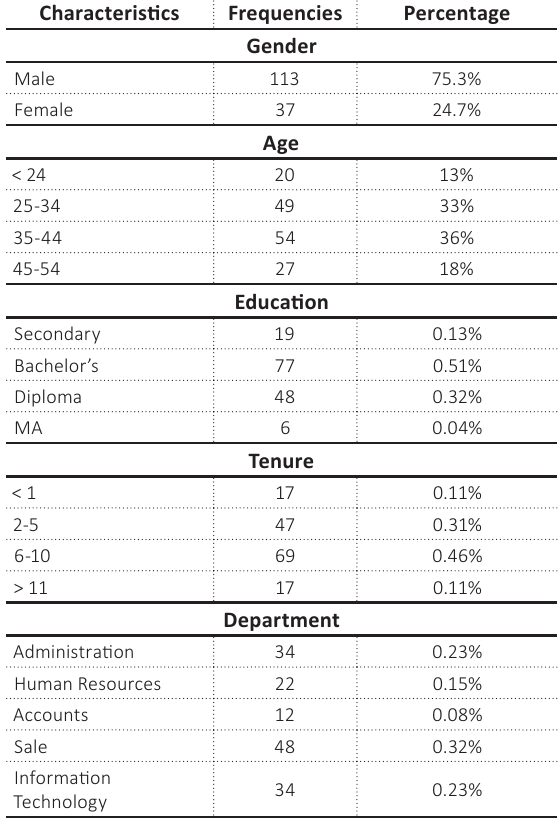
Table 1. Demographic profile of respondents